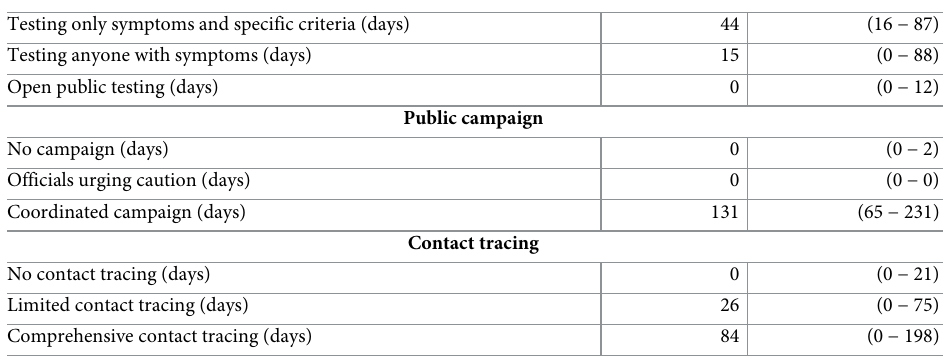
PLOS ONE | https://doi.org/10.1371/journal.pone.0264893 April 8,